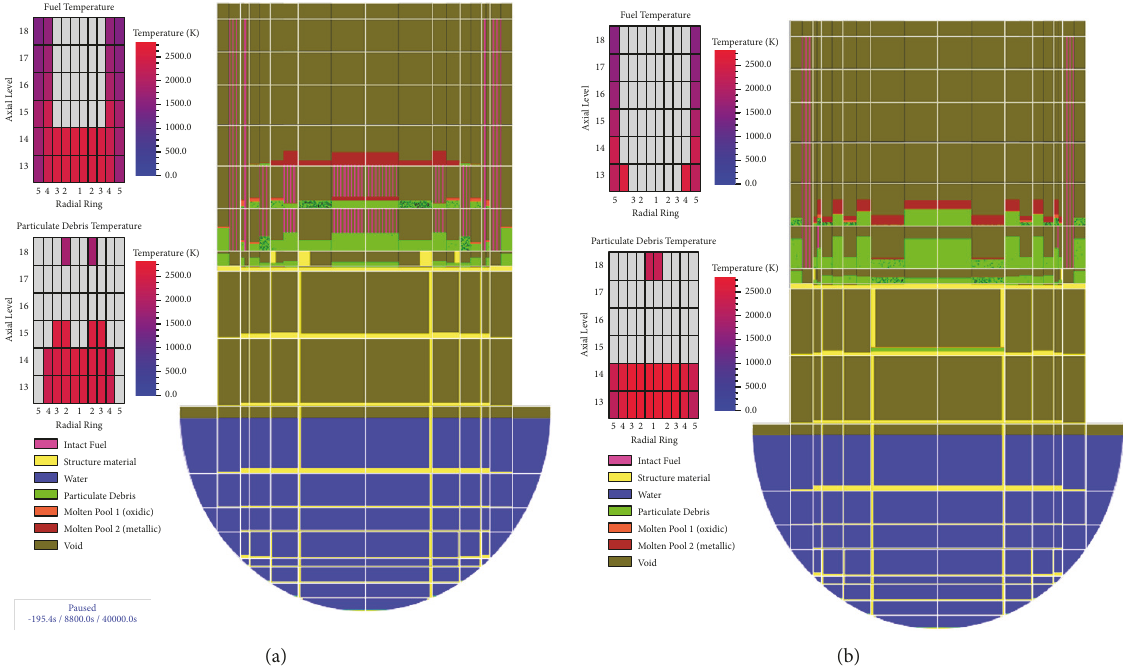
Figure 13: Core damage state for scenario with ADS time = 5500 sec and ECCS time = 9500sec at 8800sec with (a) MELCOR 2.2 and (b) MELCOR